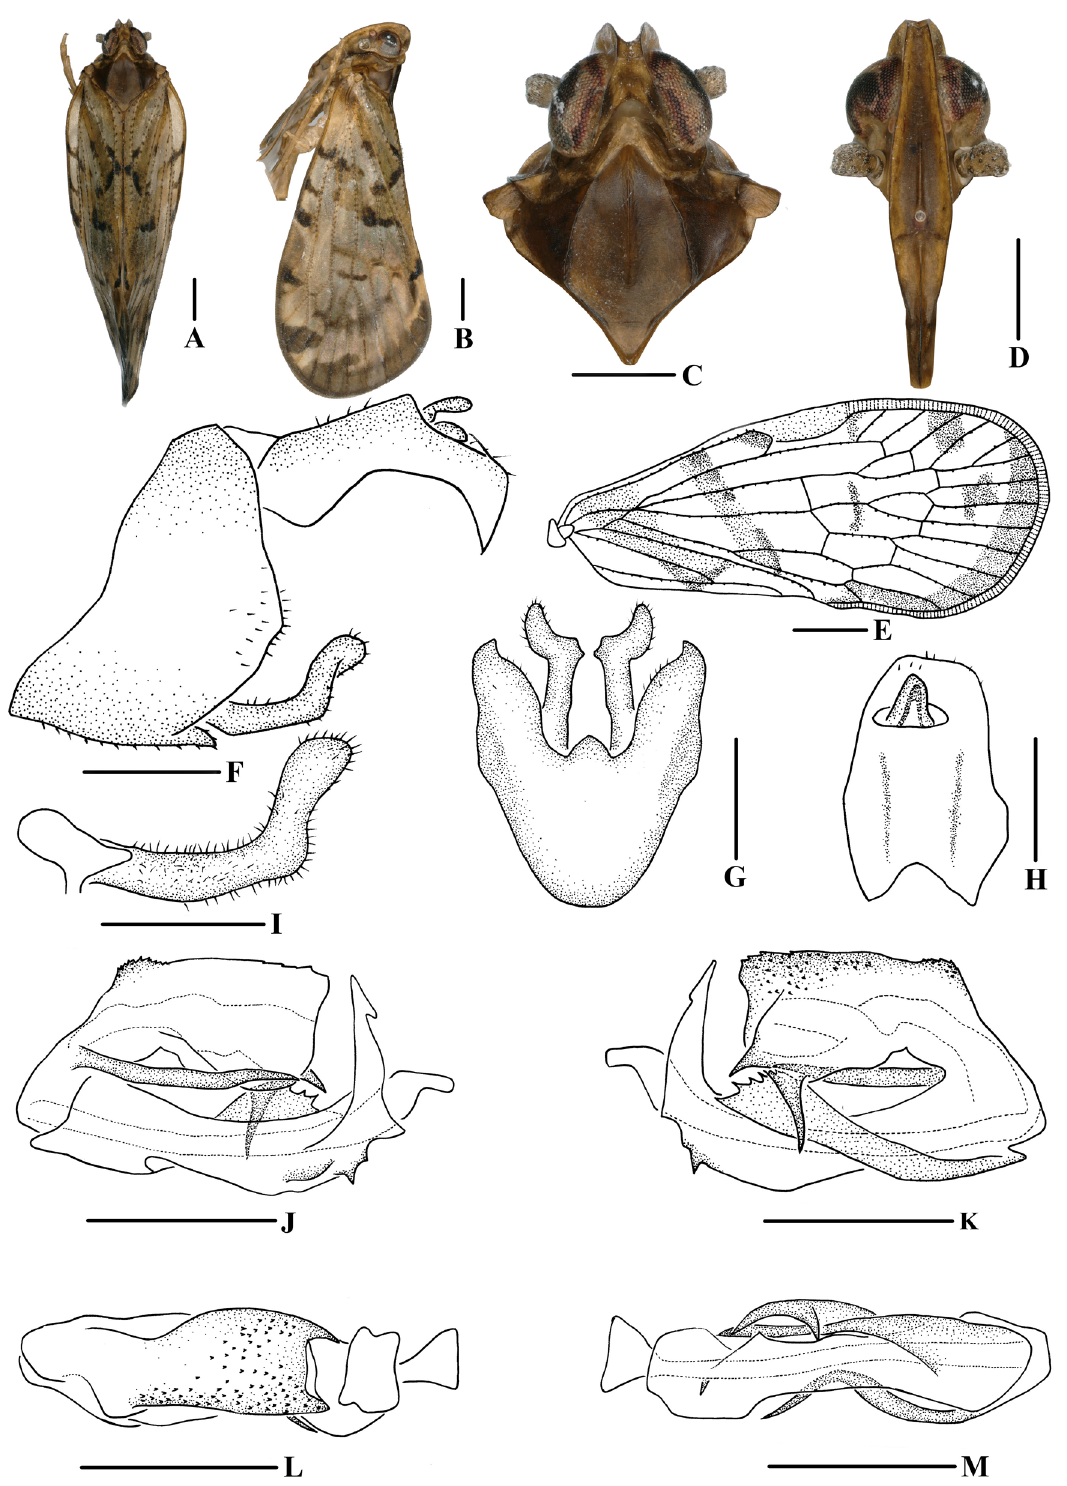
Fig. 1. Andes balteiformis Wang, Zhi & Chen sp. nov., ♂. A . Dorsal view. B . Lateral view. C . Head and thorax, dorsal view. D . Face, ventral view. E . Forewing. F . Genitalia, lateral view. G . Pygofer and gonostyli, ventral view. H . Anal segment, dorsal view. I . Gonostyli, lateral view. J . Aedeagus, right side. K . Aedeagus, left side. L . Aedeagus, dorsal view. M . Aedeagus, ventral view. Scale bars: A–D, F–M = 0.5 mm; E = 1.0